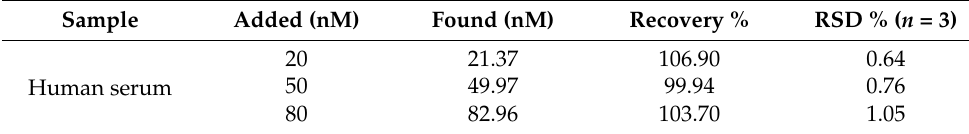
Table 2. The detection of lysozyme in human